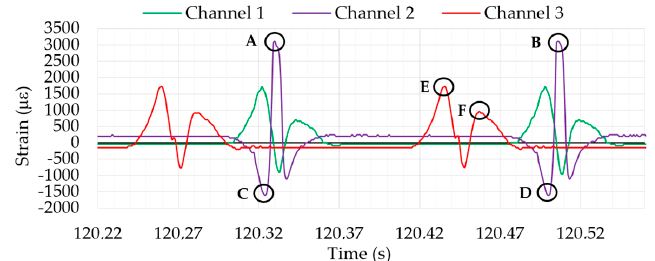
Figure 5. Example of strain data collected.